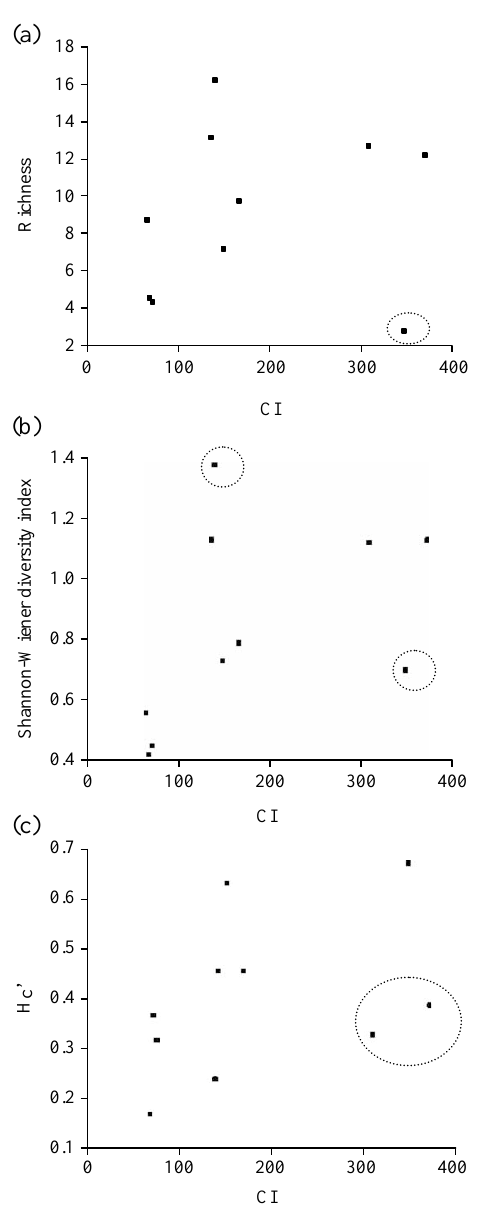
Fig. 5. Relationships among composition index (CI), species richness (SR ), Shannon-Wiener diversity index ( H ’), and coverage weighted foliage-height diversity index ( H c ’)